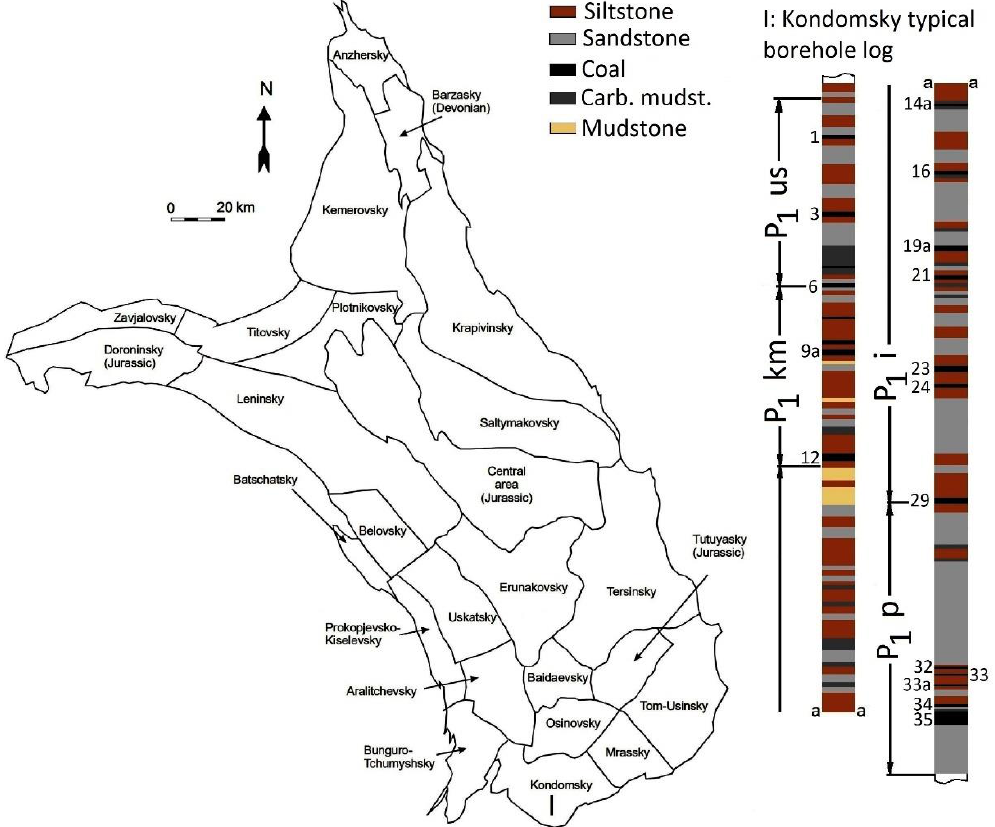
Figure 1. Division of the Kuznetsk Basin into exploration deposits [25] and a simplified borehole log of the Kondomsky deposit [26].